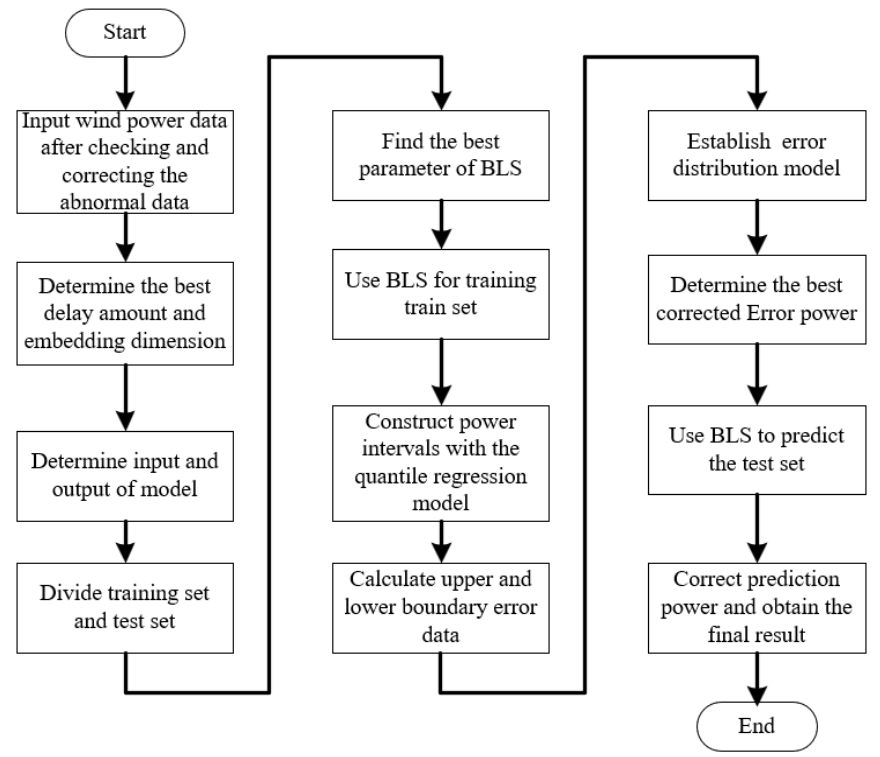
Figure 2. The process of the rolling prediction correction model.